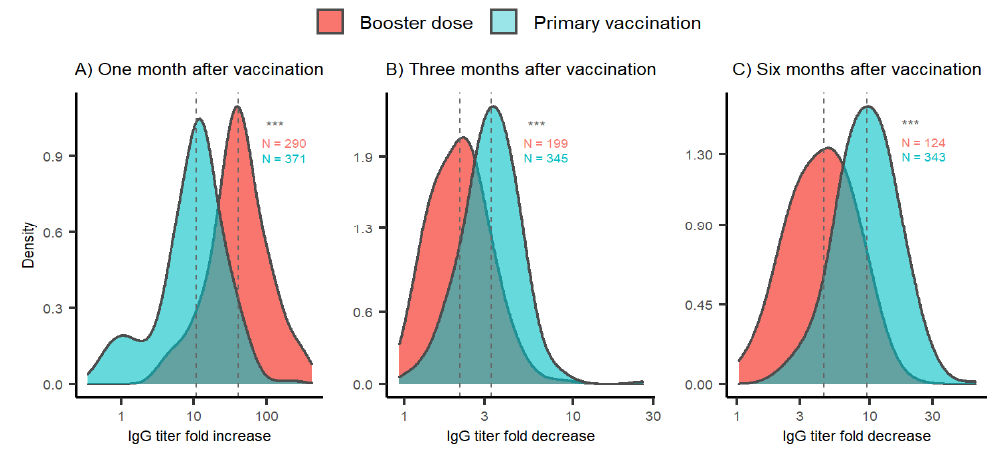
Figure 2. Anti-SARS-CoV-2 titer fold change distribution after primovaccination (blue) and booster vaccination (red). ( A ) Titer fold changes one month after vaccination calculated relative to IgG titers before the respective vaccination. ( B , C ) Titer fold changes three and six months after vaccination calculated relative to IgG titer one month after the respective vaccination. Sera of participants ac- quired after COVID-19 onset were not included. The x-axis is logarithmically scaled to increase res- olution. The y-axis represents the Gaussian kernel density estimate of the probability density func- tion. Dotted grey lines denote medians of IgG level fold change distributions. Sample sizes are in- dicated alongside the respective distribution. *** p < 0.001 (Wilcoxon signed-rank test).